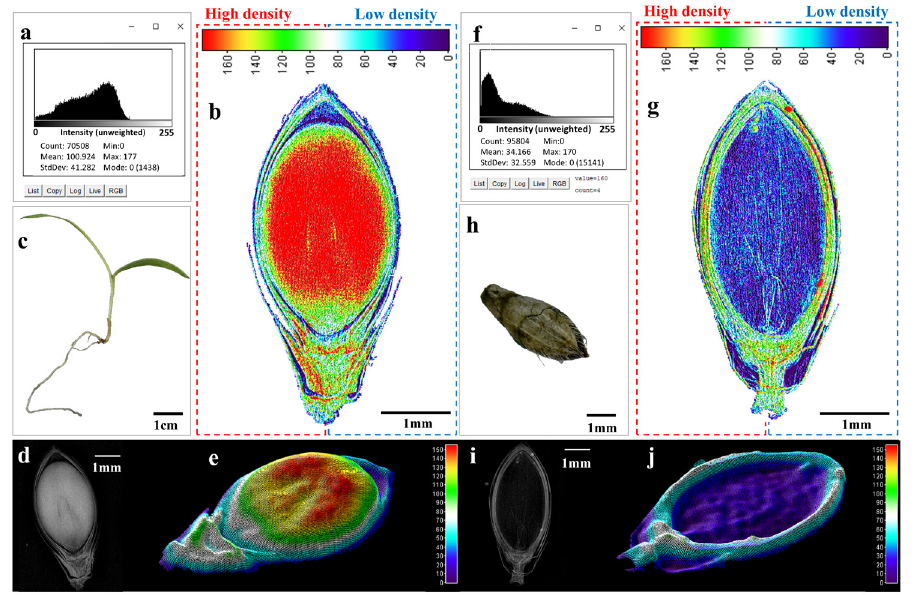
Figure 6. Images representative of two Brachiaria ruziziensis seeds with gray level histograms (a and f), 2D (b and g) and 3D (e and j) representations in density color gradient across the seed, original X-ray image (d and i), and their respective seedlings or non- germinated seed (c and